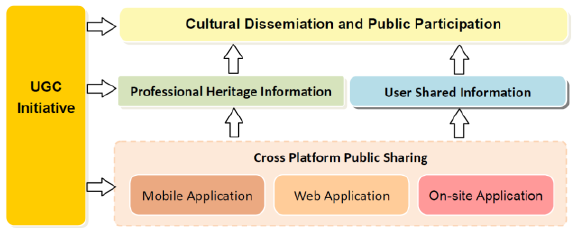
Figure 10. UGC and Public